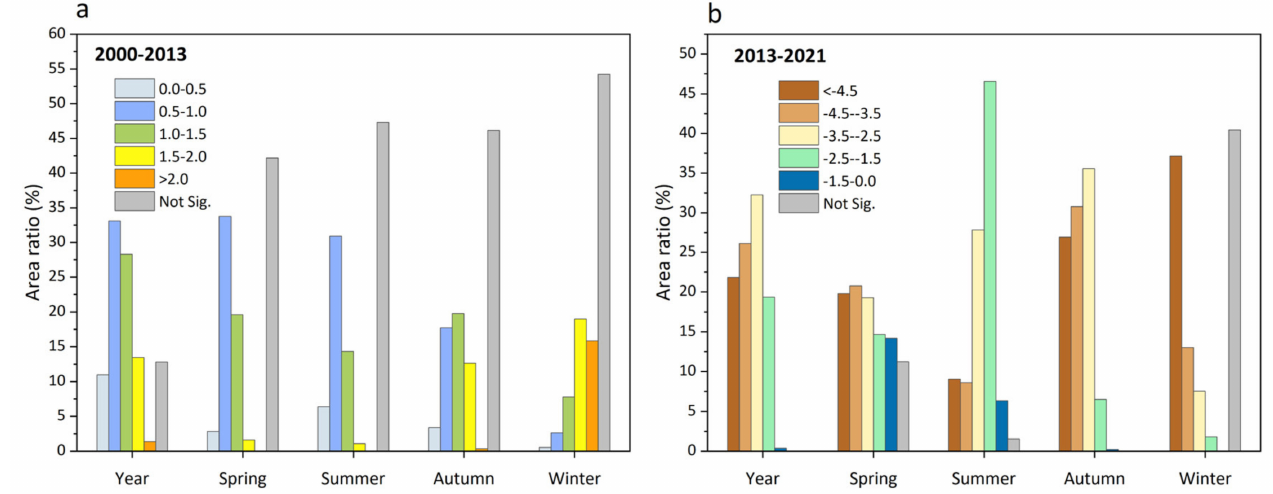
Figure 6. Trend changes of PM 2.5 concentrations in the five UAs over the period ( a ) 2000–2013 and ( b ) 2013–2021. “Not Sig.” means the confidence level was greater than 0.05. The color of the bar chart represents the Sen’s slope (unit: µ g/m 3 /y). A Sen’s slope value greater than 0 indicates an increasing trend in PM 2.5 concentrations, while a value less than 0 indicates a decreasing trend in PM 2.5